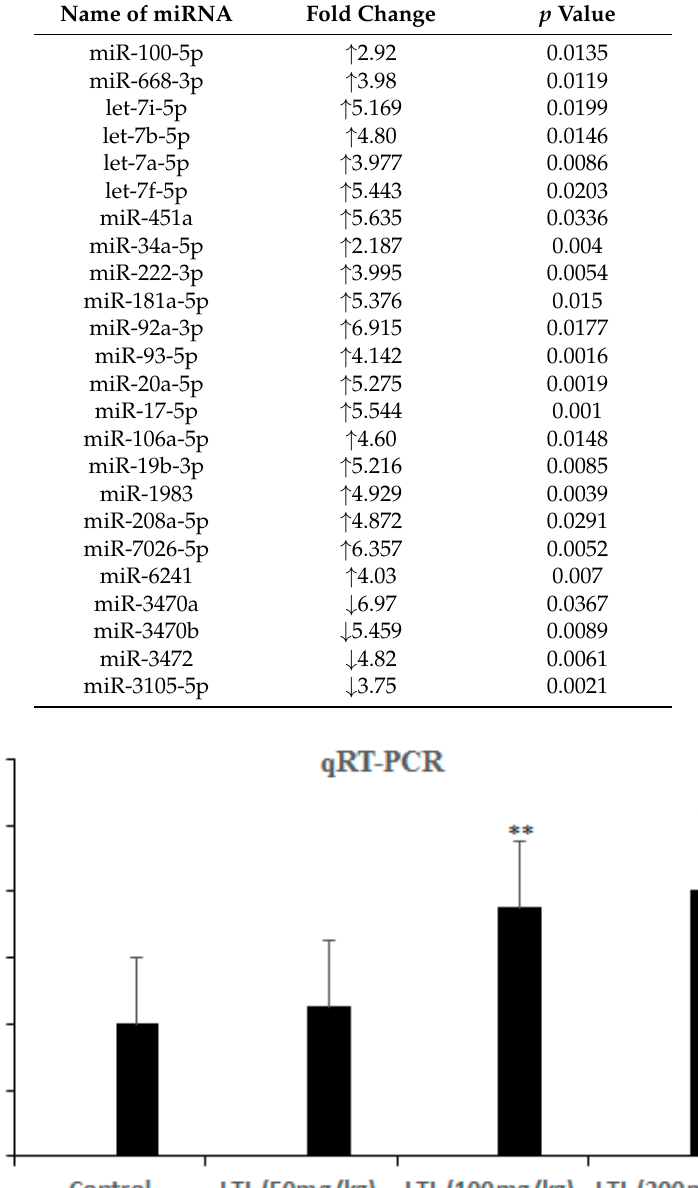
Table 1. Significantly upregulated or downregulated miRNAs upon LTL (luteolin) treatment (200 mg/kg) in vivo. Arrows represent upregulation ( ↑ ), or downregulation ( ↓ ).